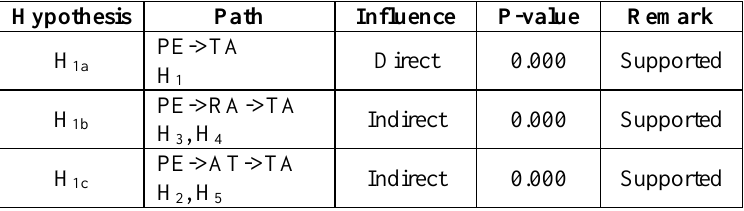
Table 2: Findings of Direct and Indirect